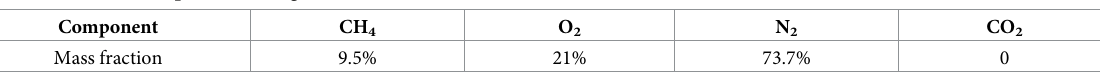
Table 3. The initial component of the gas.